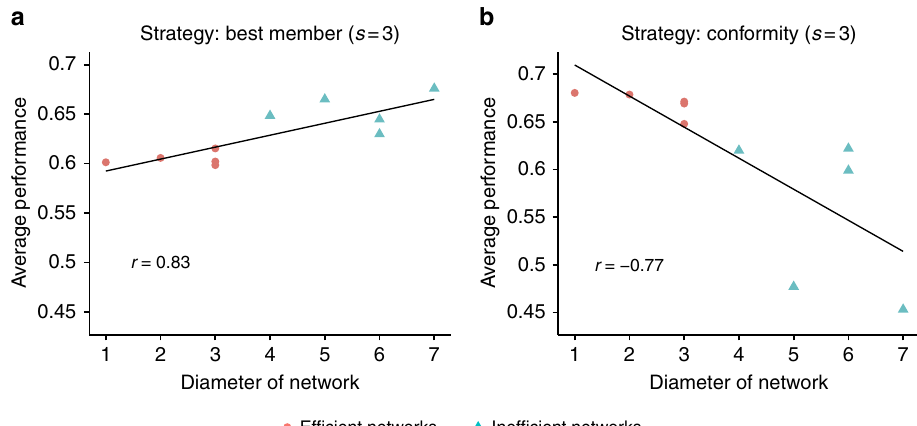
Figure 4 | Relationship between network diameter and average performance. ( a ) Individuals rely on the best member ( s ¼ 3) strategy; ( b ) individuals rely on the conformity ( s ¼ 3) strategy. Red circles indicate efficient networks and turquoise triangles indicate inefficient networks. Straight lines show best linear fits. The relationship between diameter and performance is positive when individuals rely on the best member strategy (Pearson correlation coefficient r ¼ 0.83) and is negative when they rely on the conformity strategy ( r ¼ (cid:2)